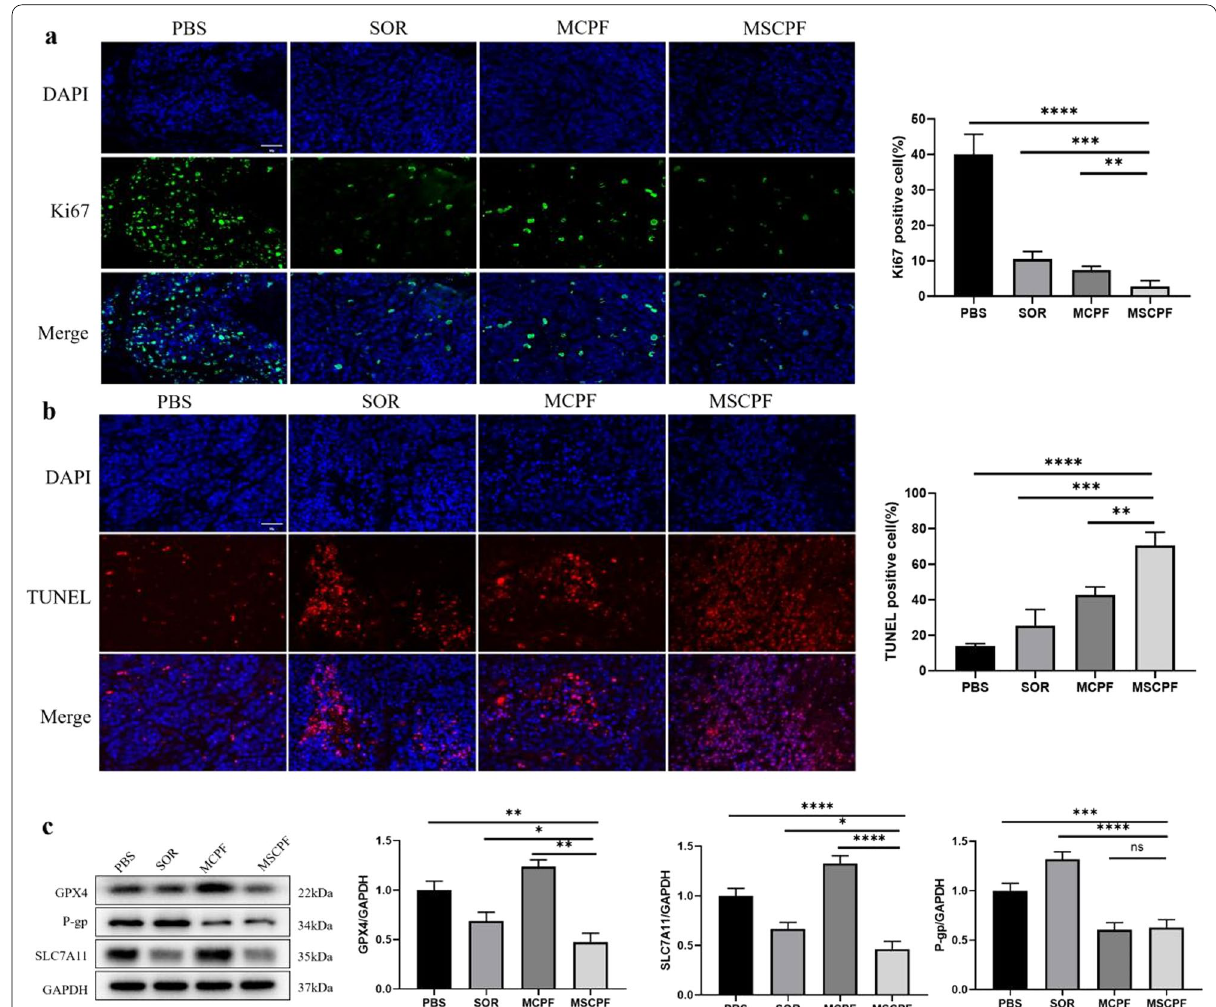
Fig. 8 a Ki67 staining of the tumor tissue of mice treated with PBS, SOR, MCPF, or MSCPF upon irradiation. b TUNEL staining of the tumor tissue of mice treated with PBS, SOR, MCPF, or MSCPF upon irradiation. c GPX4, SLC7A11 and P-gp expressions in SMMC-7721 xenograft models treated by PBS, SOR, MCPF, or MSCPF upon